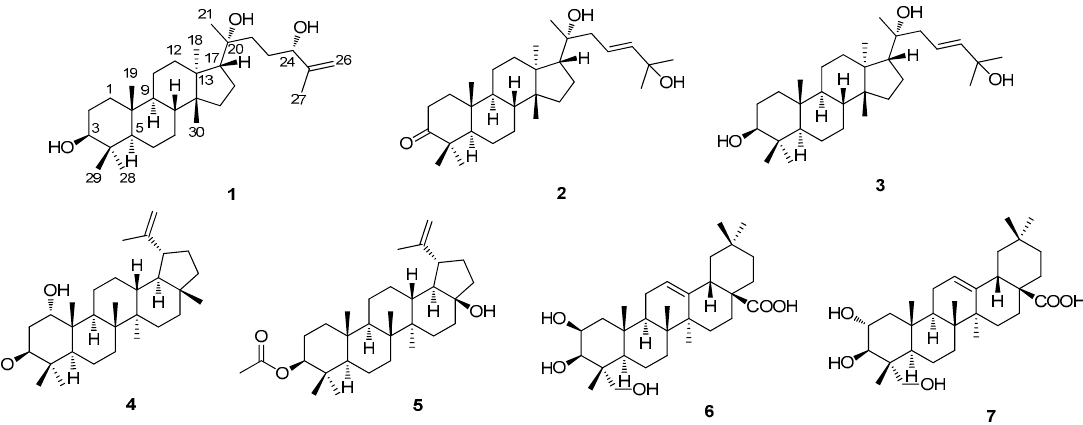
Figure 1. Chemical structures of compounds 1 – 7 from C. walteri .